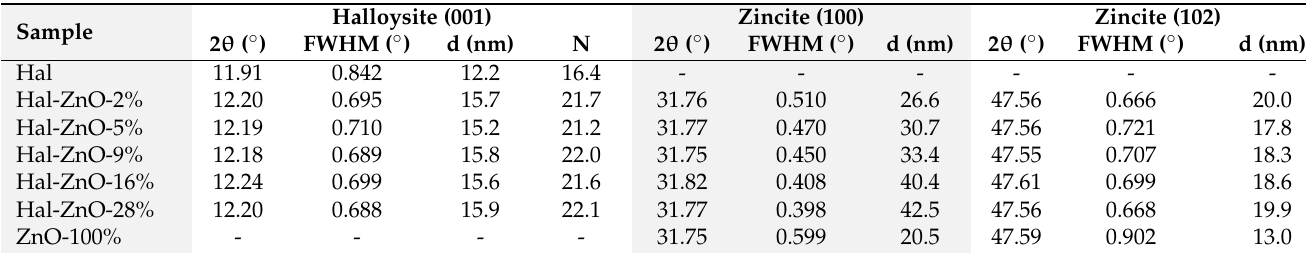
Figure A1. Structural and compositional identification of the halloysite-Zn(OH) 2 composite samples with different Zn content by powder X-ray diffraction measurements. The dashed line indicates the d (001) value of halloysite. The as-synthesized halloysite-Zn(OH) 2 composite samples before heat-treatment at 350 °C are denoted with “(80 °C)”. Table A1. Average crystallite size (d) of halloysite and zincite. The determined d (001) interlayer distance values were applied when the average number of halloysite TO layers (N) were calculated by the Scherrer